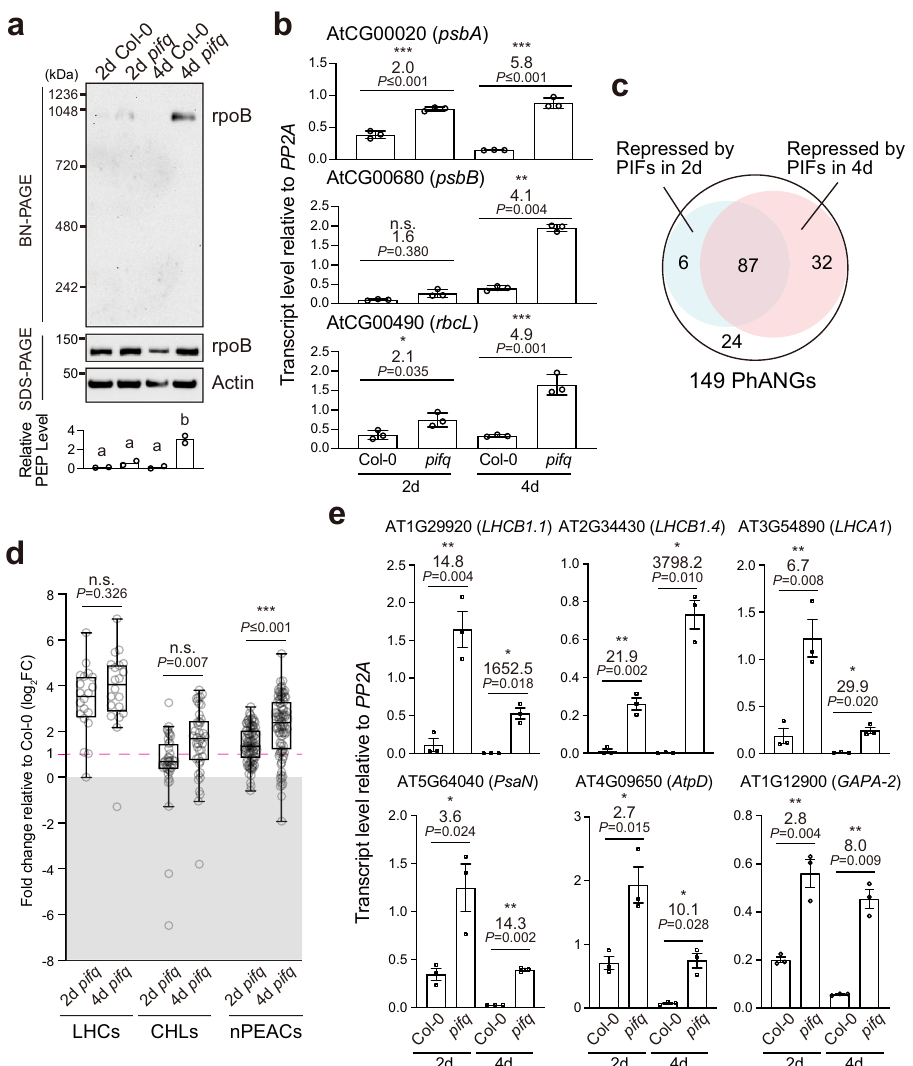
Fig. 3 | Genome-wide activation of PhANGs is insuf fi cient to fully activate the PEP in pifq . a Immunoblots showing the levels of the PEP complex and its core componentrpoBin2-d-oldand 4-d-oldCol-0and pifq seedlings growninthe dark. Total protein was isolated under either native or denaturing conditions and resolved via BN-PAGE or SDS-PAGE to assess the fraction of rpoB in the PEP com- plex or the amount of total rpoB by immunoblots, respectively. The bar graph shows the quali fi cation of the relative levels of the PEP complex, which were cal- culatedusingtherelativelevelofrpoBinthePEPcomplex(BN-PAGE)dividedbythe relative level of the total rpoB (SDS-PAGE) in each sample. Different letters denote statistically signi fi cant differences in the relative PEP levels among the genotypes (ANOVA, Tukey ’ s HSD, P ≤ 0.05, n =2). b qRT-PCR analysis of the steady-state transcript levels of psbA , psbB , and rbcL in 2-d-old and 4-d-old Col-0 and pifq seedlings grown in the dark. The transcript levels were calculated relative to those of PP2A . The fold changes between the transcript levels in the mutants and Col-0 are shown. Asterisks indicate statistically signi fi cant differences in the transcript levelsbetweenthemutantandCol-0basedontwo-tailedStudent ’ s t -test(* P ≤ 0.05, ** P ≤ 0.01, *** P ≤ 0.001). If the change was less than two-fold or not statistically sig- ni fi cant, it is labeled as n.s. (not signi fi cant). Error bars represent the s.e. of three biological replicates, and the centers of the error bars represent the mean values. c Venn diagram showing PIF-repressed PhANGs in 2-d-old and 4-d-old dark-grown